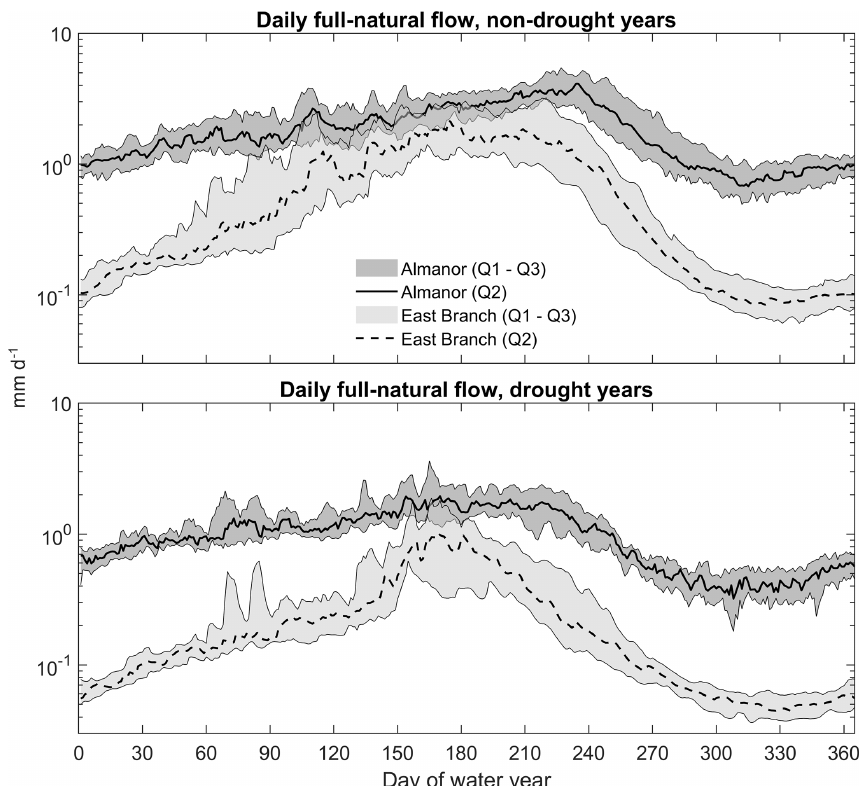
Figure 3. Daily median ( Q 2 ) and quartiles ( Q 1 and Q 3 ) of observed full-natural flow during drought and non-drought years at the outlet of two headwater basins of the Feather River with contrasting lithology. The Almanor sub-basin is a predominantly volcanic, subsurface-flow- fed sub-basin; East Branch is transitional to granitic and surface-runoff-dominated. The y axis is in log scale.